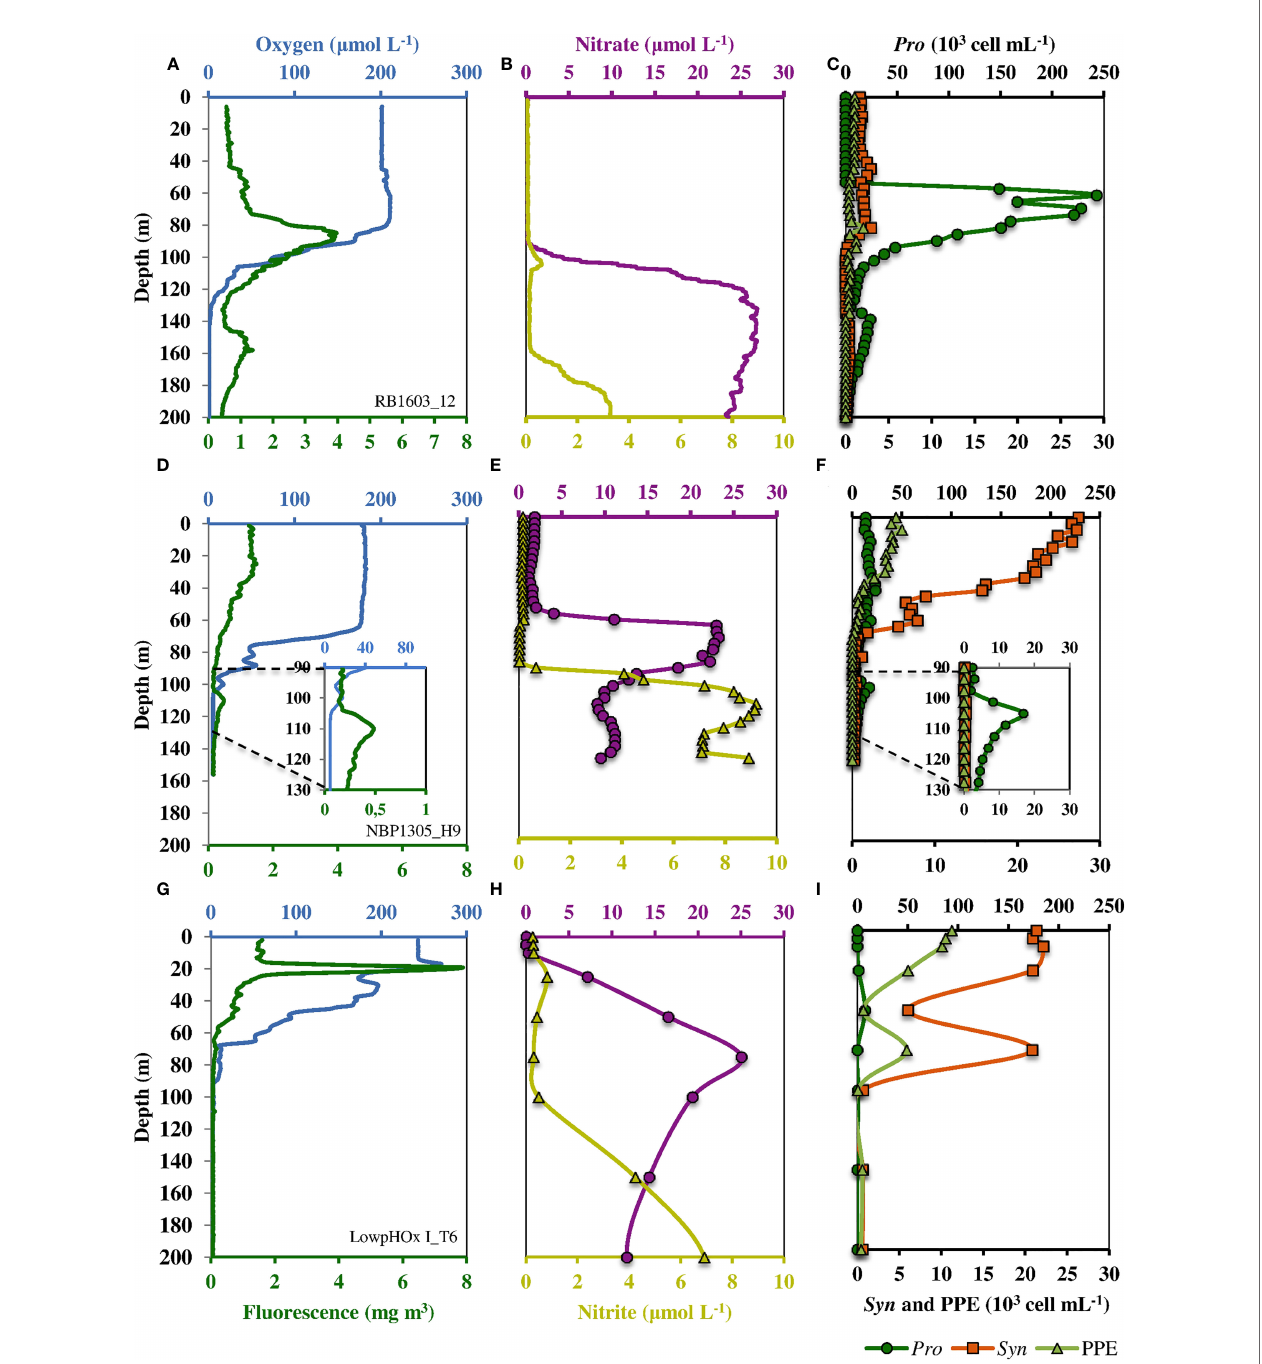
FIGURE 2 | Example vertical structures of water columns and picoplankton with strong, weak, and no SCM at the top of the oxygen-de fi cient layer in the AMZs. Panels (A – C) represents a strong SCM in the ETNP (cruise RB1603, station 12); panels (D – F) represent a weak SCM in the ETSP (cruise NBP1305, station H9); and panels (G – I) represent an example when no SCM was present in the ETSP (cruise LowpHOx I, station T6). Left panels show oxygen and fl uorescence pro fi les (CTD + fl uorometer). Middle panels show nitrate and nitrite pro fi les measured in continuous fl ow coupling the PPS and an autoanalyzer (B) and a discrete sampling (E, H) . Right panels show cell count (×10 3 cell mL − 1 ) pro fi les of picophytoplankton components obtained by a high-resolution sampling analyzed by fl ow cytometry. Dark green circles indicate Prochlorococcus , light green triangles indicate PPE, and orange squares represent orange- fl uorescent